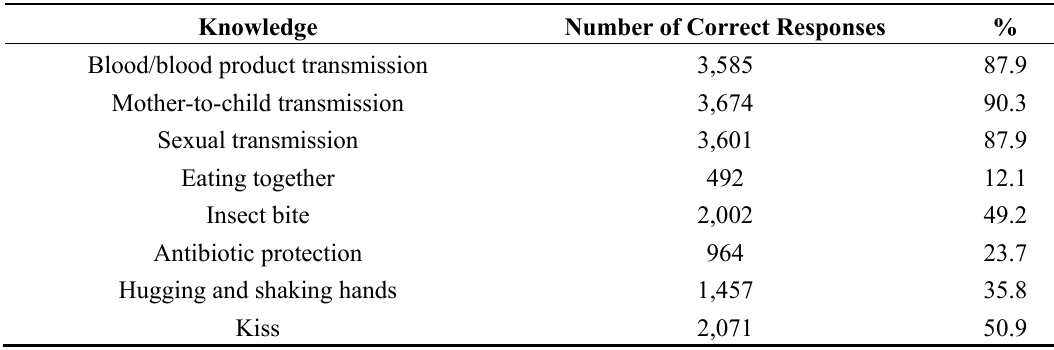
Table 2. HIV/AIDS-related knowledge among migrants ( n =